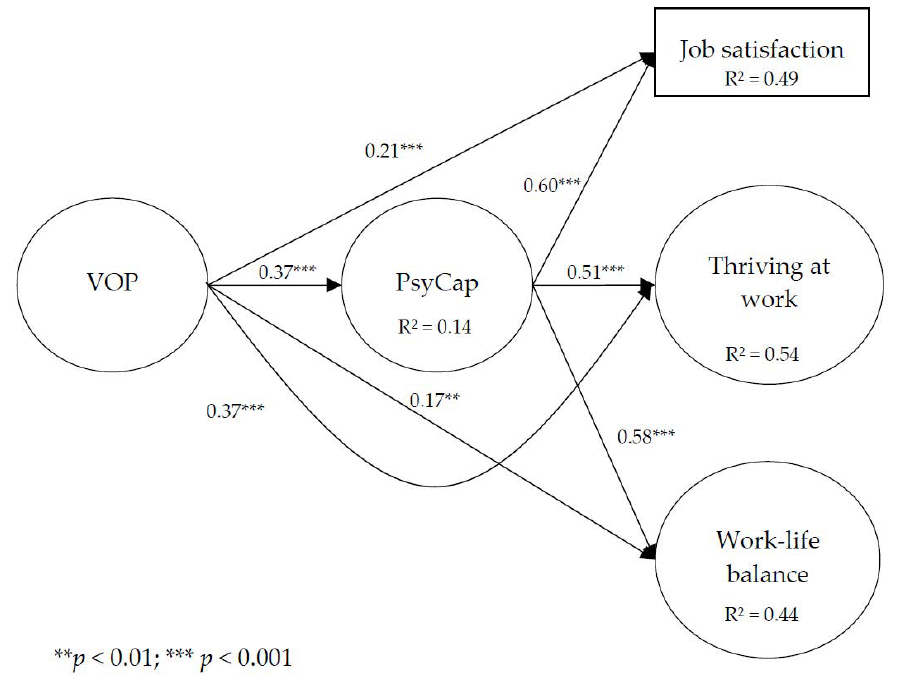
Figure 1. Results of the Hypothesized